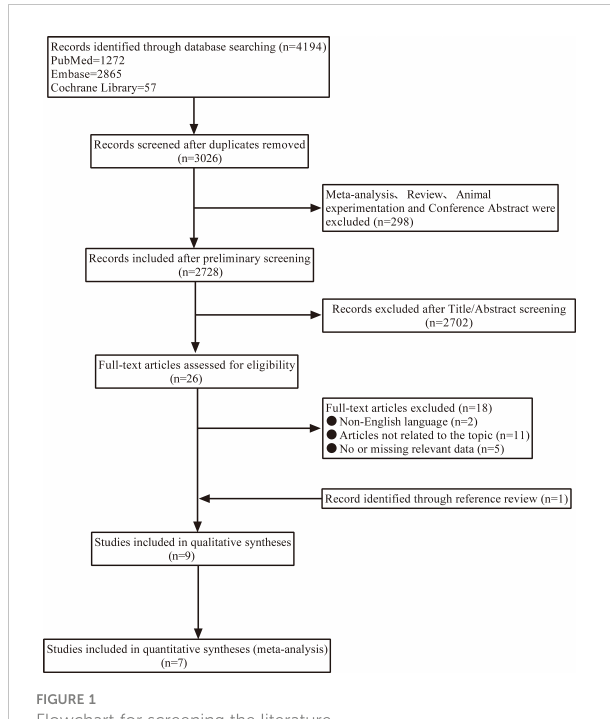
FIGURE 1 Flowchart for screening the